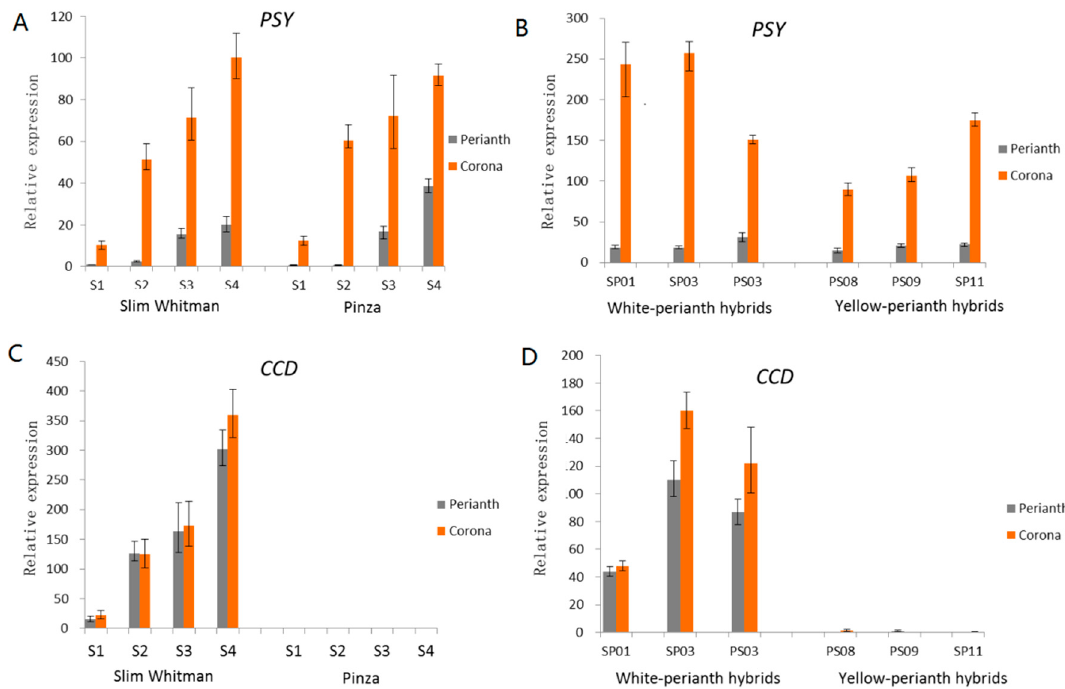
Figure 6. The expression pattern of unigene c100891.graph_c0 ( PSY ) and c77684.graph_c0 (Carotenoid cleavage deoxygenases ( CCD )) by qRT-PCR. The Actin was used as an internal control for normalization. Total RNA was extracted from the perianth and corona at different flowering stages. ( A ) The expression pattern of PSY in perianths and coronas of SW and PZ from S1 to S4. ( B ) The expression pattern of PSY in perianths and coronas during S4 of six hybrids of SW and PZ. ( C ) The expression pattern of CCD in perianths and coronas of SW and PZ from S1 to S4. ( D ) The expression pattern of CCD in perianths and coronas during S4 of six hybrids of SW and PZ. SP01, SP03, and PS03 were white-perianth hybrids; PS08, PS09, and SP11 were yellow-perianth hybrids.